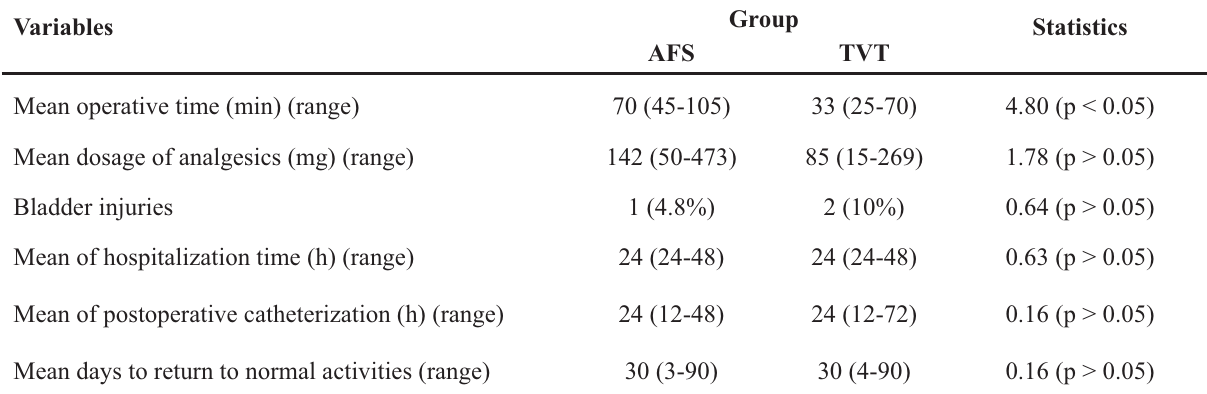
Table 2 – Outcome of autologous fascial sling (AFS) and tension-free vaginal tape (TVT). Variables Group